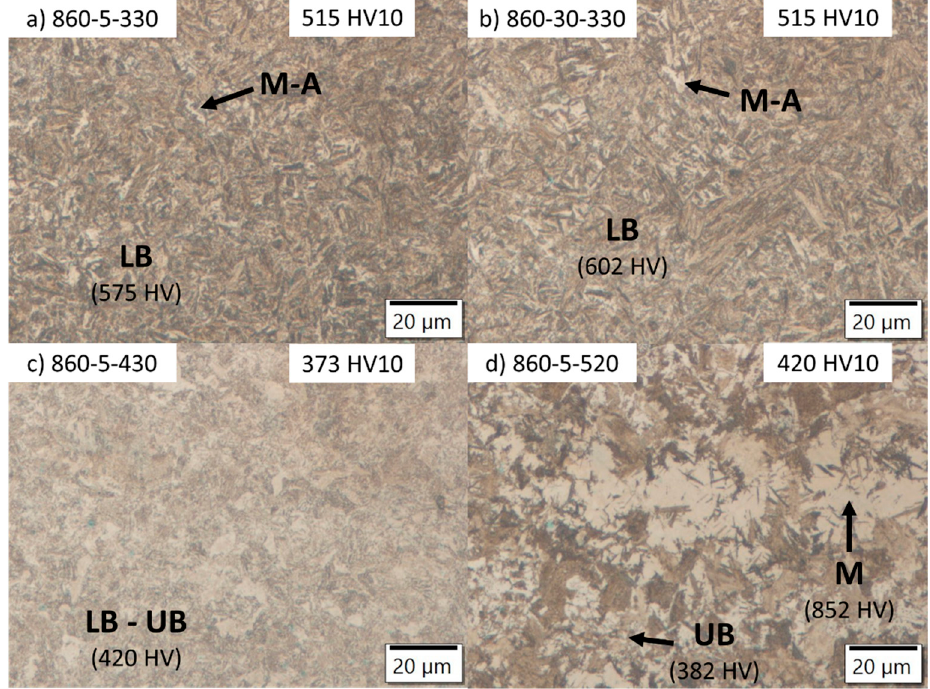
Figure 8. Optical microscopy of etched samples at 500× magnification after different heat treatments. ( a ) Austenitisation at 860 °C for 5 min followed by bainite transformation at 330 °C, ( b ) austenitisa- tion at 860 °C for 30 min followed by bainite transformation at 330 °C, ( c ) austenitisation at 860 °C